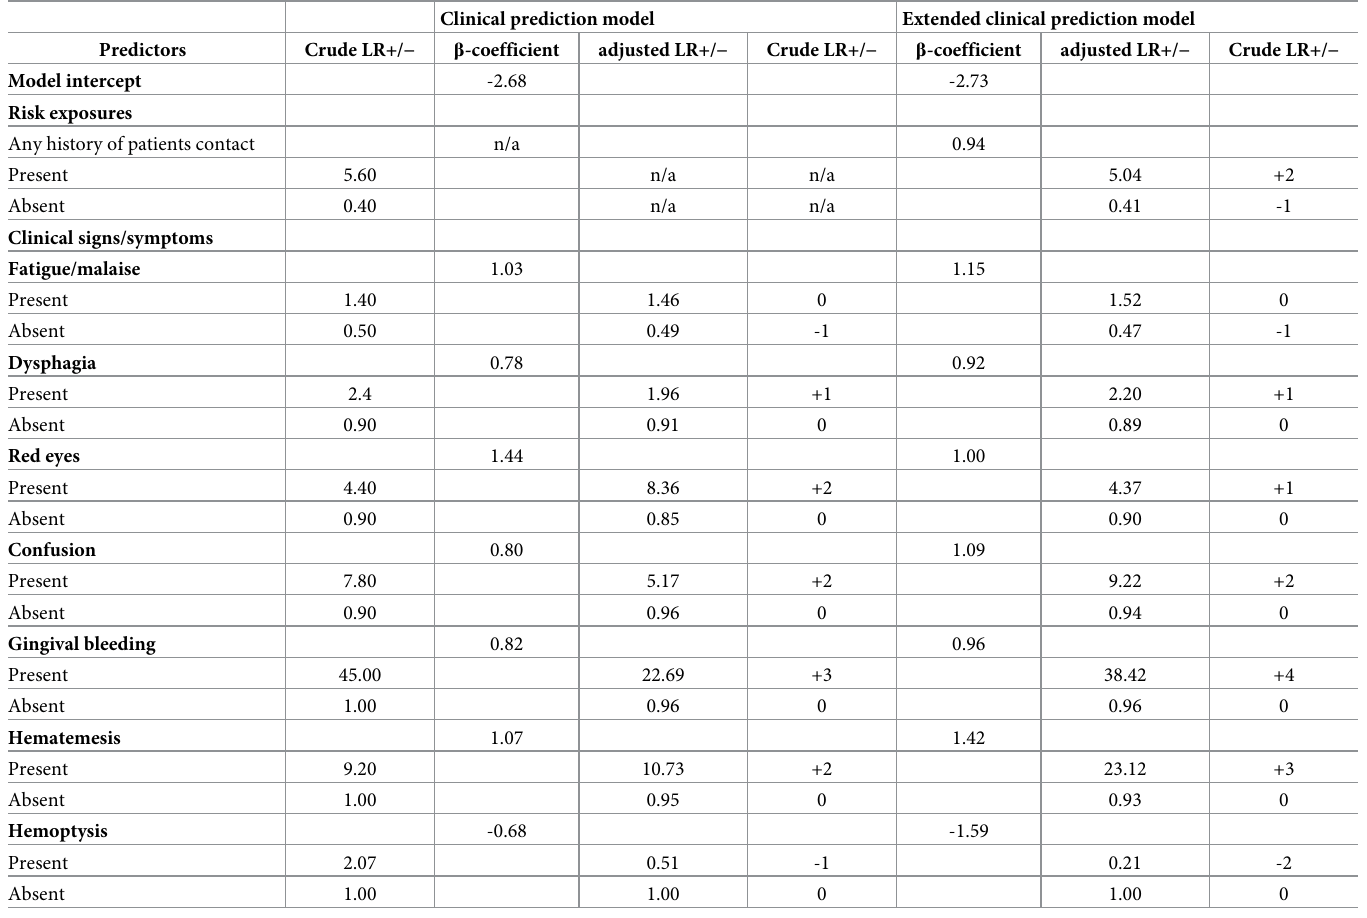
Table 3. Crude and weighted score developed for clinical and extended clinical model score